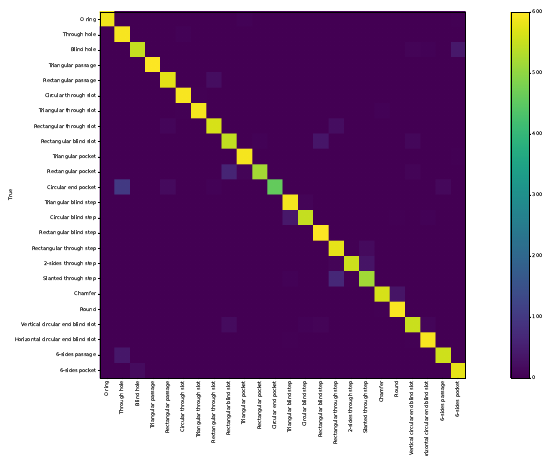
Figure A5. Confusion matrix for [40].